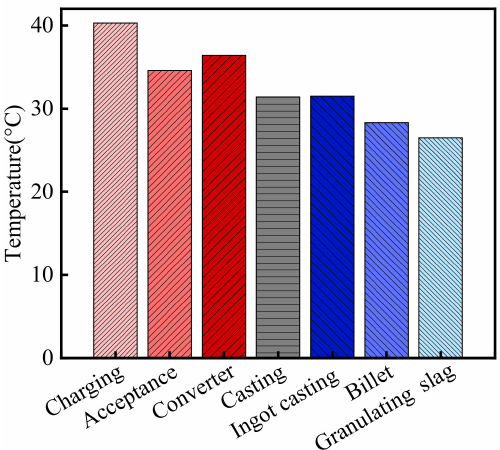
Figure 1. The temperature in the steelworks.